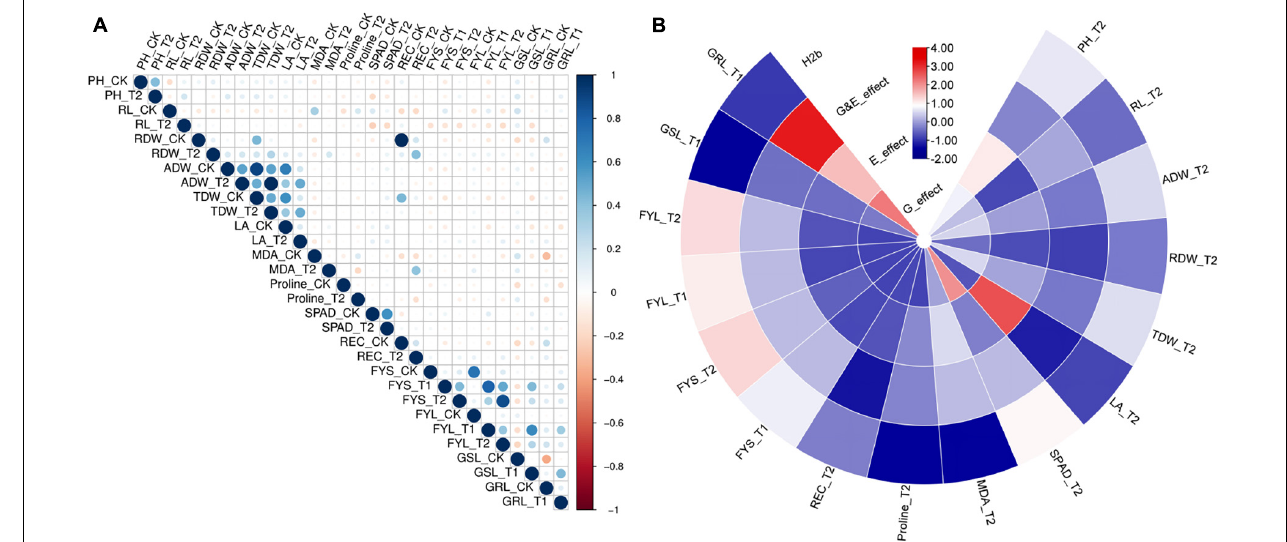
FIGURE 1 | Evaluation of correlation coefficient, heritability, and genetic & treatment effect of all traits under normal and salt stress conditions at germination and seedling stages. (A) Heat map showing Pearson’s correlations (r) among all traits of the 505 B. napus accessions assessed under normal and salt stress conditions (CK, control; T1, 150 mM NaCl; and T2, 215 mM NaCl) at germination and seedling stages in the greenhouse. (B) Heat map showing Broad-sense heritability, genetic, and treatment effect. H2b, broad-sense heritability; E_effect, treatment effect; G_effect, genetic effect and G&E_effcet; interaction of genetic and treatment effects. Germination stage: FYS, germination potential; FYL, germination rate; SL, shoot length and GRL, shoot length. Seedling stage: PH, plant height; RL, root length; RDW, root dry weight; TDW, total dry weight; LA, leaf area; MDA, Malondialdehyde content; SPAD, chlorophyll content; Proline, proline content and REC, Relative electrical